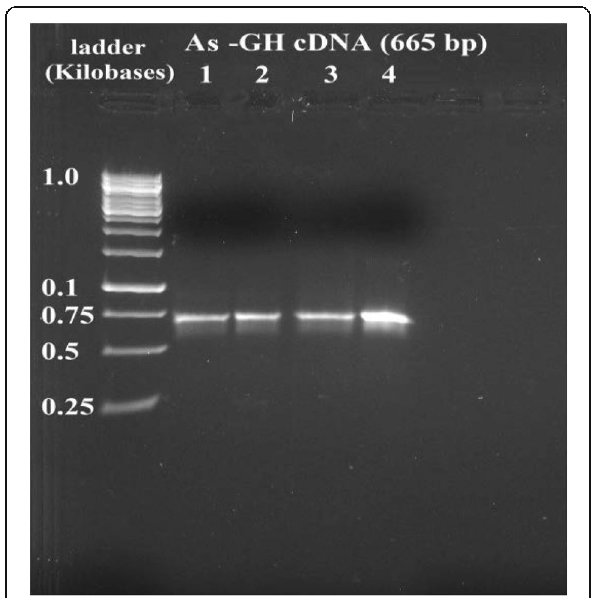
Fig. 1 Gel electrophoresis bands of As_GH cDNA